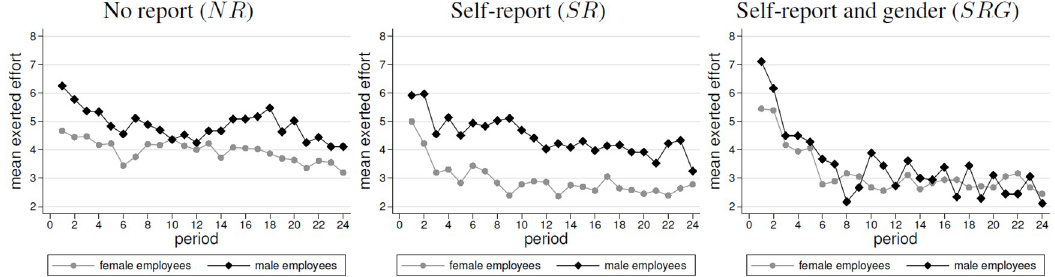
Fig 1. Average exerted efforts by treatment and gender (order: NR , SR , SRG